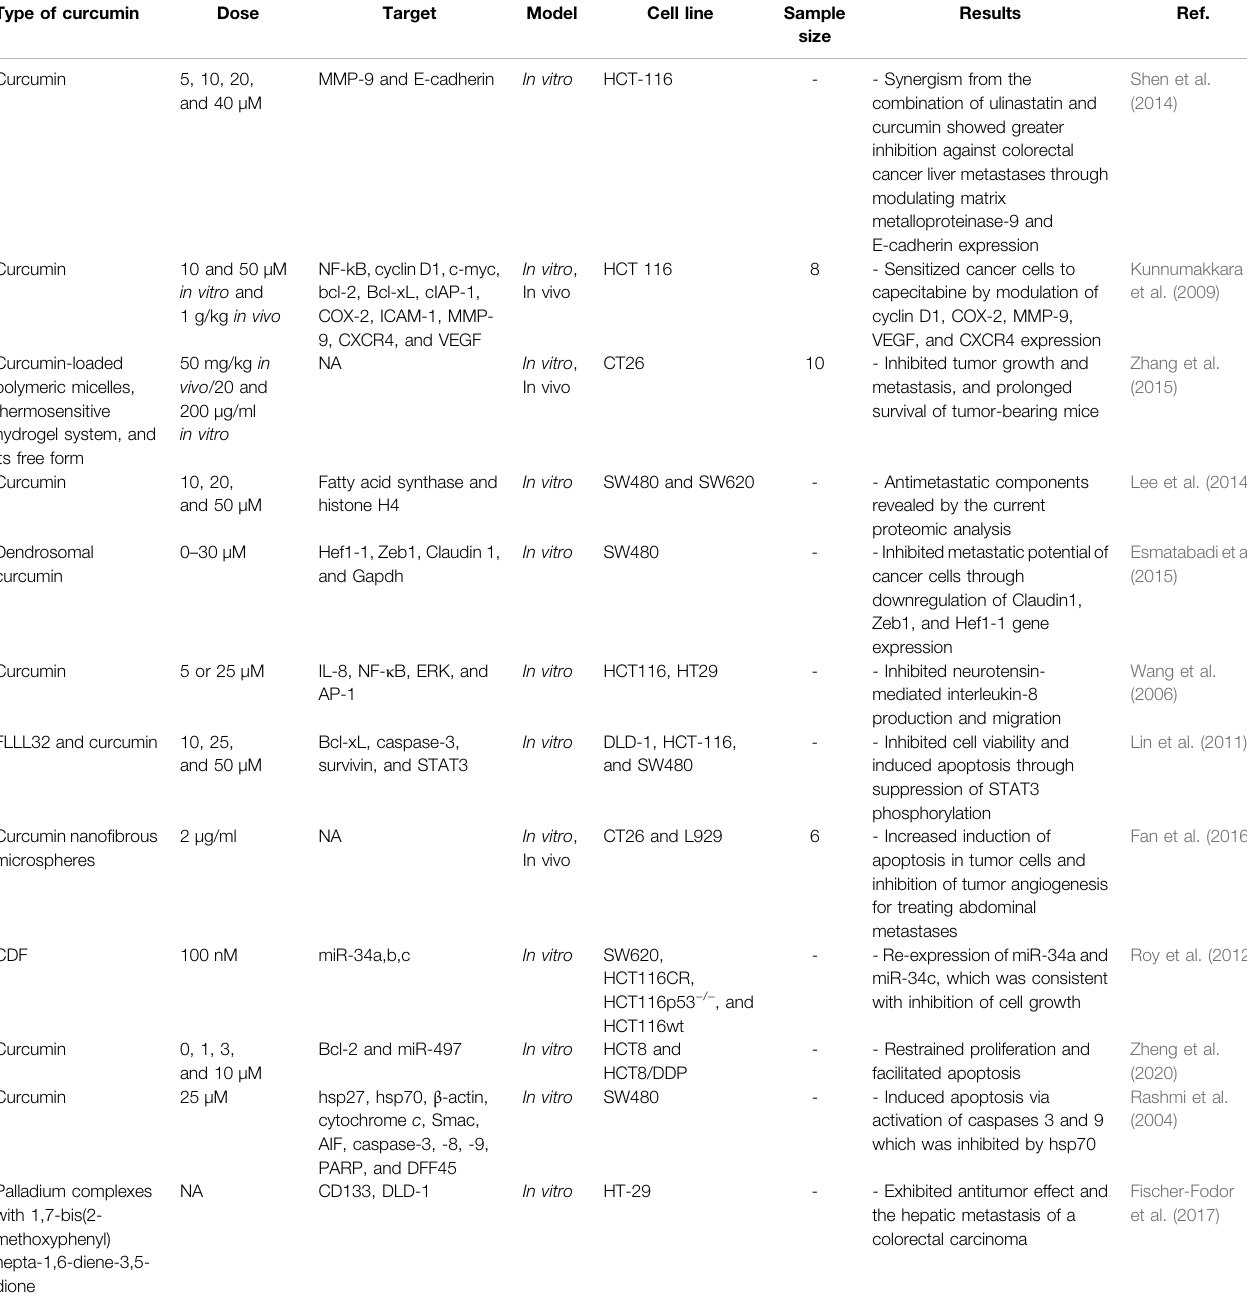
TABLE 3 | ( Continued ) Curcumin-induced antimetastatic effects against colorectal